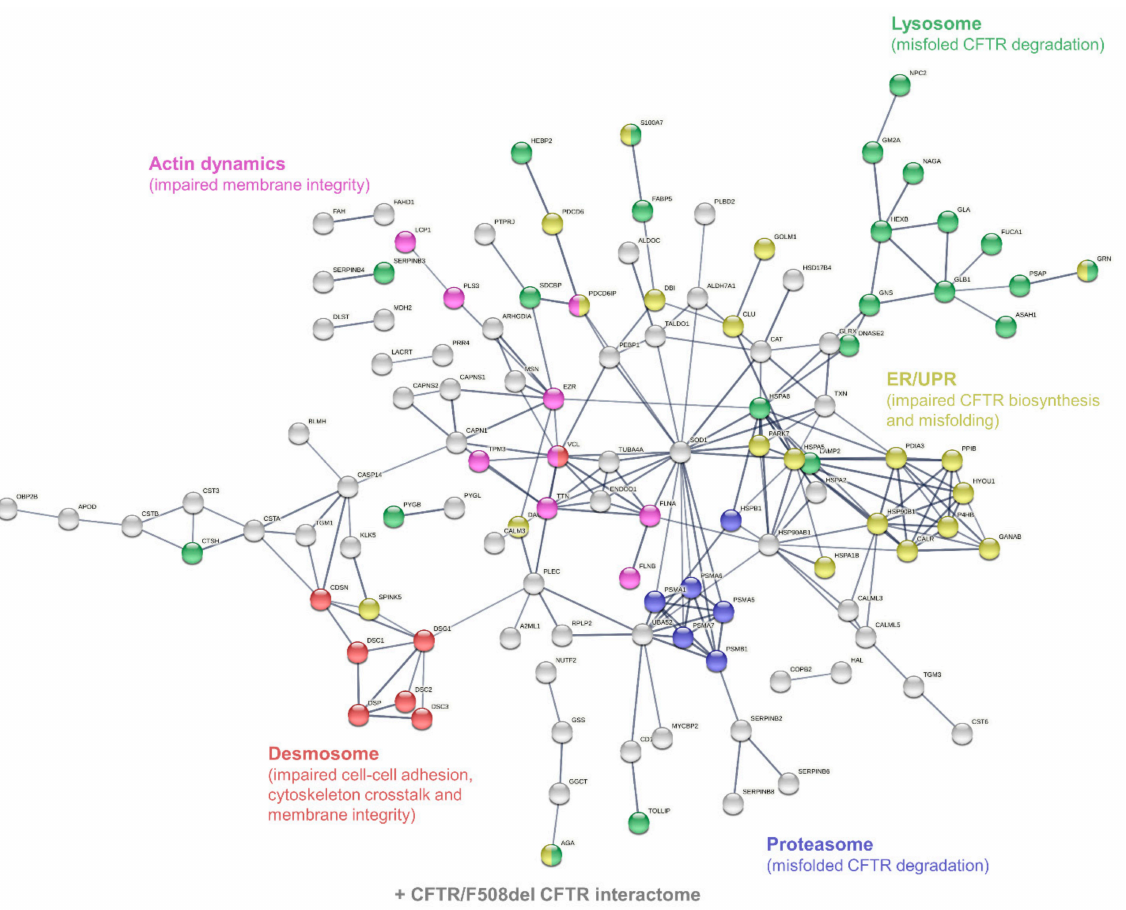
Figure 5. Interaction network mapping of sweat core CF biomarkers (182 proteins in 42/42 samples). The 182 query proteins resulted in 180 mapped proteins. Network settings included: Homo sapiens database, high confidence minimum required interaction score, hidden disconnected nodes, and confidence-based